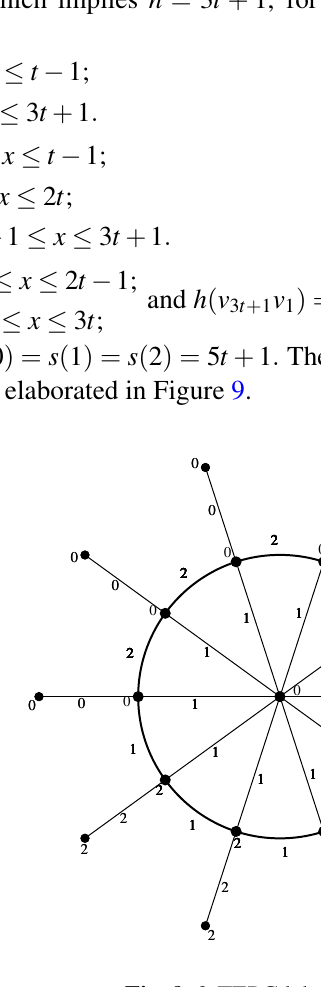
Fig. 9 3-TEPC labeling of H